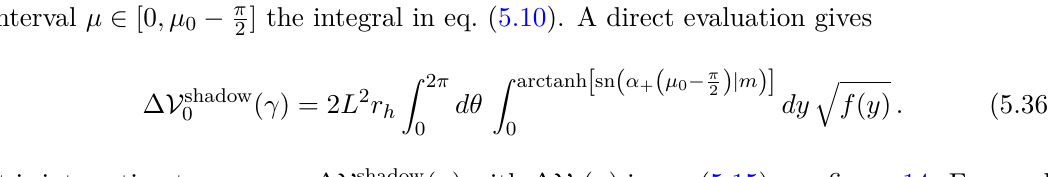
as a fuction of γ . The numerical value r 0